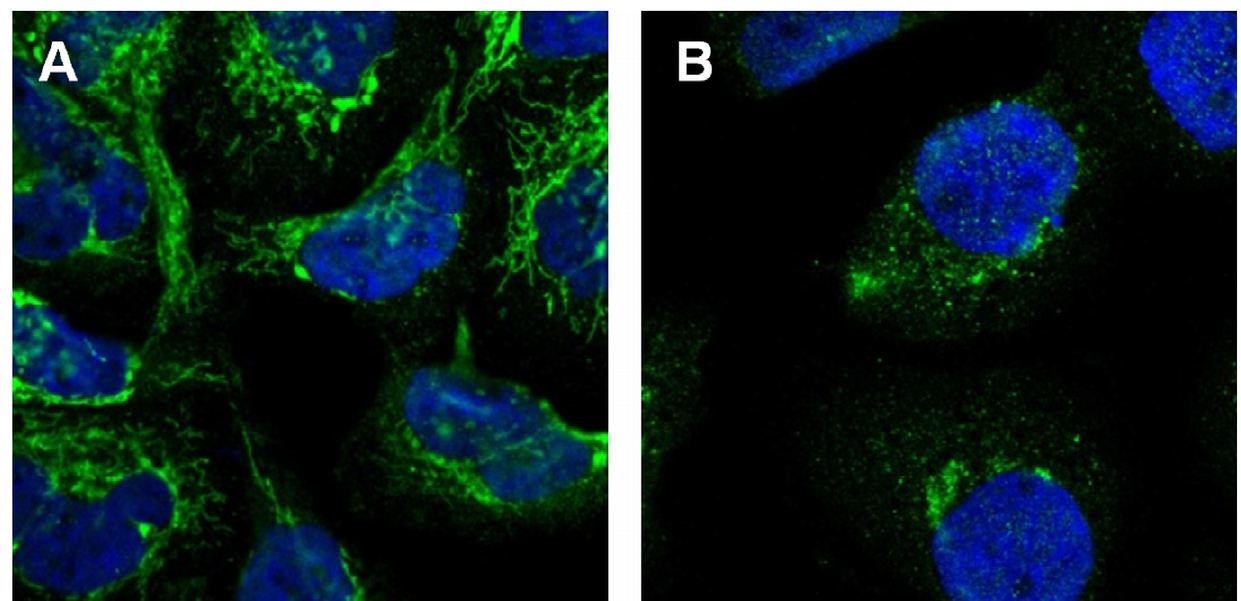
Figure 2. Examples of mis-annotated proteins identified by the SVM classification reannotation algorithm. (a) Protein ‘‘Thiosulfate sulfurtransferase’’ was identified in the first round analysis. The protein was visually annotated as ‘‘cytoskeleton’’ but was classified as ‘‘mitochondria’’ by an SVM classifier. The latter annotation was found to be correct upon re-examination. (b) Protein ‘‘proline-rich transmembrane protein 2 0 was identified in the second round analysis. The protein was visually annotated as ‘‘cytoplasm’’ but was classified as ‘‘Golgi’’ by an SVM classifier. The latter annotation was found to be correct upon re-examination.